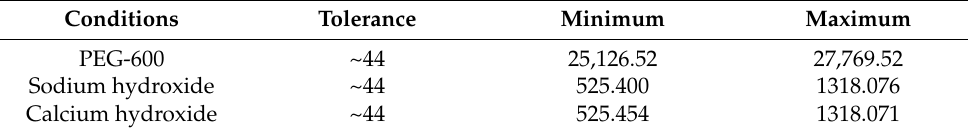
Table 8. Molecular weight of PEG depolymerized in a strong alkaline